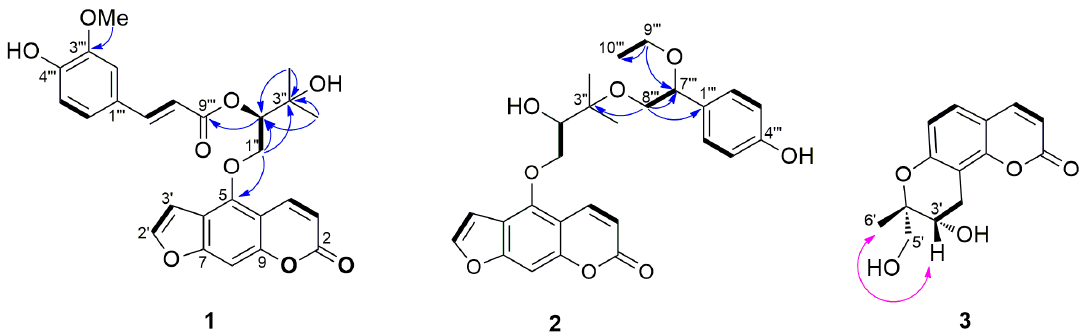
Figure 2. Key COSY ( − ), HMBC ( → ), and NOESY ( ↔ ) correlations of compounds 1 – 3 .